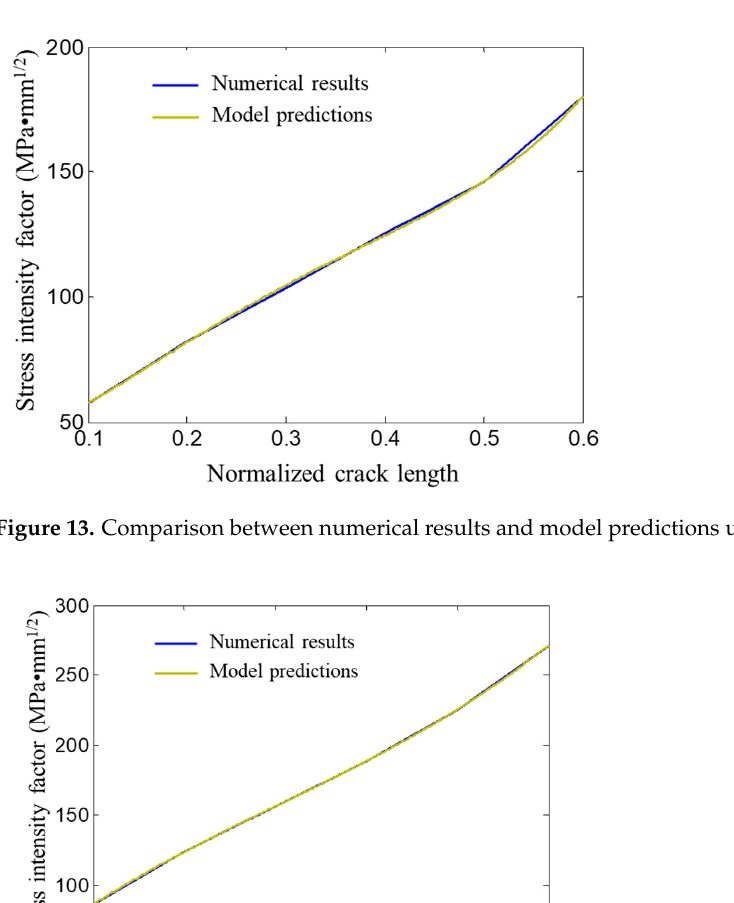
11 of 14 Figure 12. Comparison between numerical and regression results. 4.3. Model Validation In a groundbreaking move, Section 4.2 unveils the prediction model of the coveted stress intensity factor, depicted by Equation (13). This innovative model primarily lever- ages the numerical structure under the stress-inducing 100 MPa load. To further validate its efficacy with varying loads, it was subjected to the stress-inducing conditions of 200 MPa and 300 MPa. Utilizing both the XFEM method and Equation (13), the stress intensity factor at the crack tip was calculated across different normalized crack lengths. The results of these calculations are presented in Figures 13 and 14, with residuals of 0.240 and 0.166,